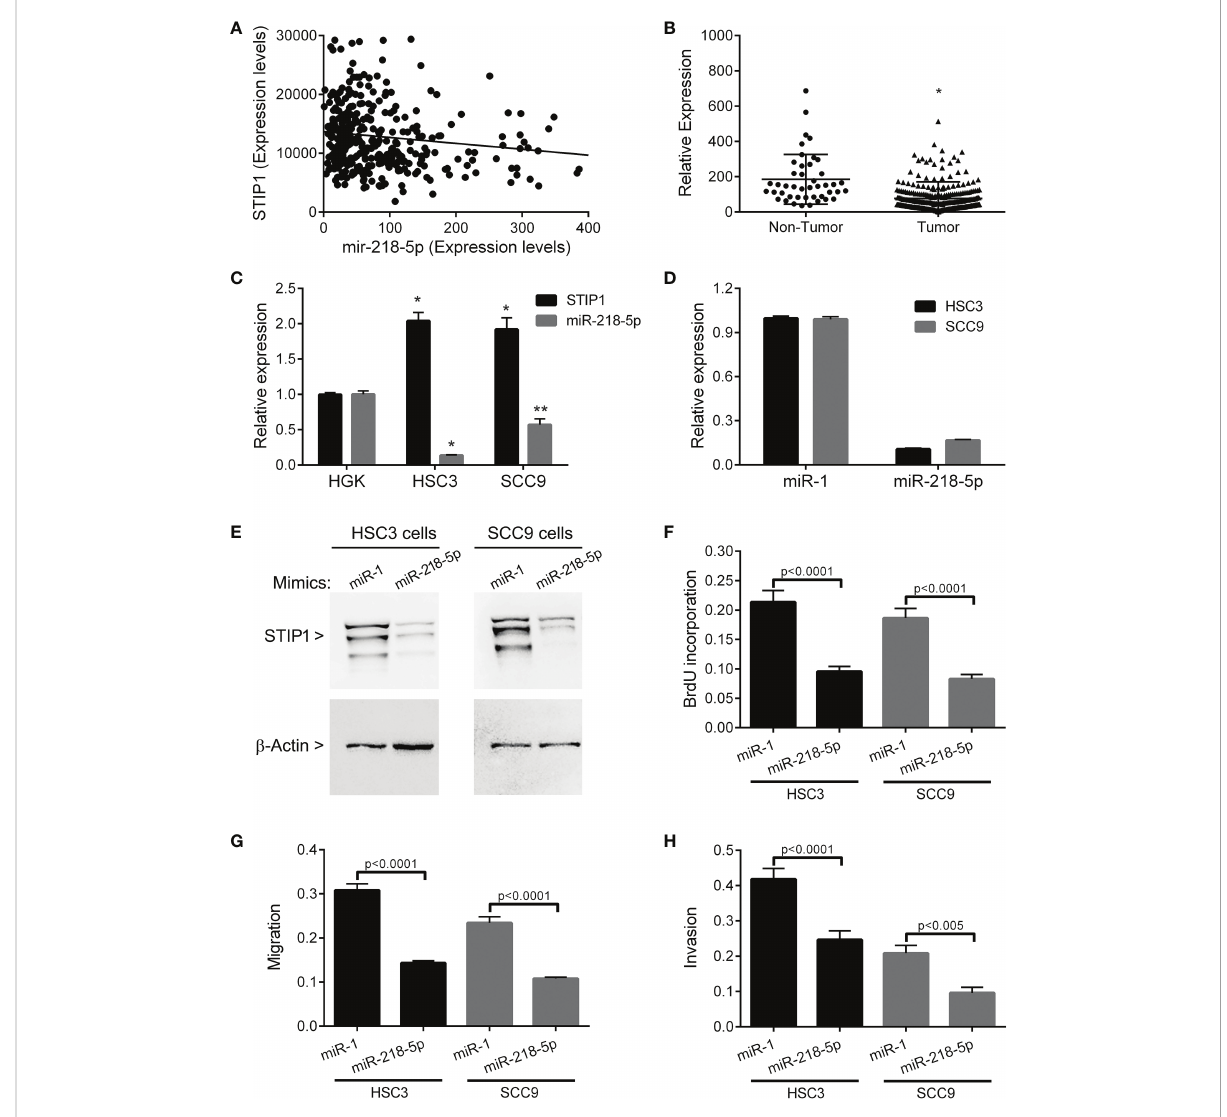
FIGURE 4 STIP1 and miR-218-5p in OSCC. (A) Expression of STIP1 is inversely correlated with miR-218-5p in OSCC samples from TCGA (rs=0.216, p=0.02). (B) The levels of miR-218-5p are down-regulated in OSCCs compared to control (non-tumor samples) (*p<0.0001). (C) There is a clear inverse correlation between STIP1 and miR-218-5p in the HSC3 and SCC9 cell lines (*p<0.0001, **p<0.005). Levels of STIP1 mRNA (D) and protein (E) were clearly decreased after transfection of miR-218-5p mimics, demonstrating that miR-218-5p regulates STIP1 mRNA levels. Forced overexpression of miR-218-5p signi fi cantly inhibited the proliferation (F) , migration (G) and invasion (H) of HSC3 and SCC9 cells. The values represent the average ± SD of three separate experiments. In fi gure (E) a representative image is